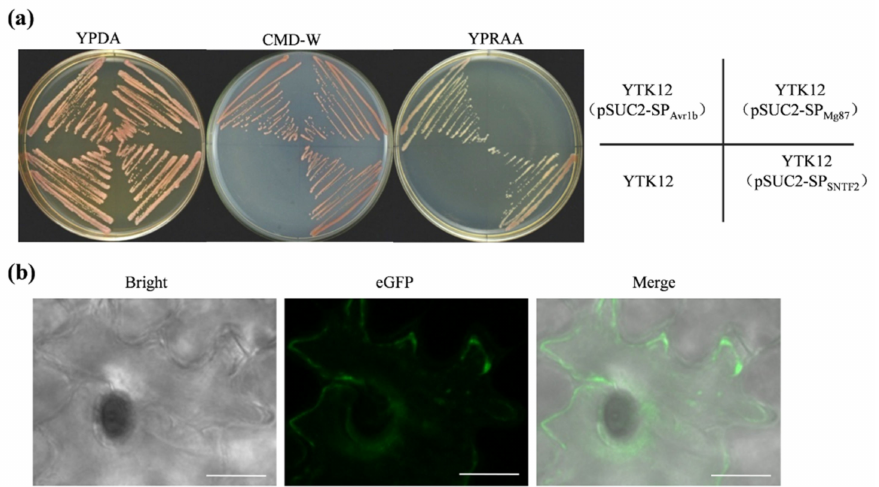
Figure 5. The secretory function validation of Sntf2. ( a ) The secretory function test of the predicted signal peptide (SP) of Sntf2 was based on the yeast’s secretory system. The YTK12 strains con- taining pSUC2-SP Avr1b (SP Avr1b : the SP sequence of Avr1b from Phytophthora sojae ) were used as a positive control, and those containing pSUC2-SP Mg87 (SP Mg87 : the first 25 amino acids of Mg87 protein from Magnaporthe oryzae ) were used as negative controls. ( b ) Sntf2-eGFP fusion protein was translocated into plant cells during apple leaf infection. The leaves were inoculated with ∆ sntf2 - 1/ gpdAp:SNTF2:eGFP strain ( gpdAp : the promoter of glyceraldehyde-3-phosphate dehydrogenase gene from Aspergillus nidulans ). Bar: 10 µ m.